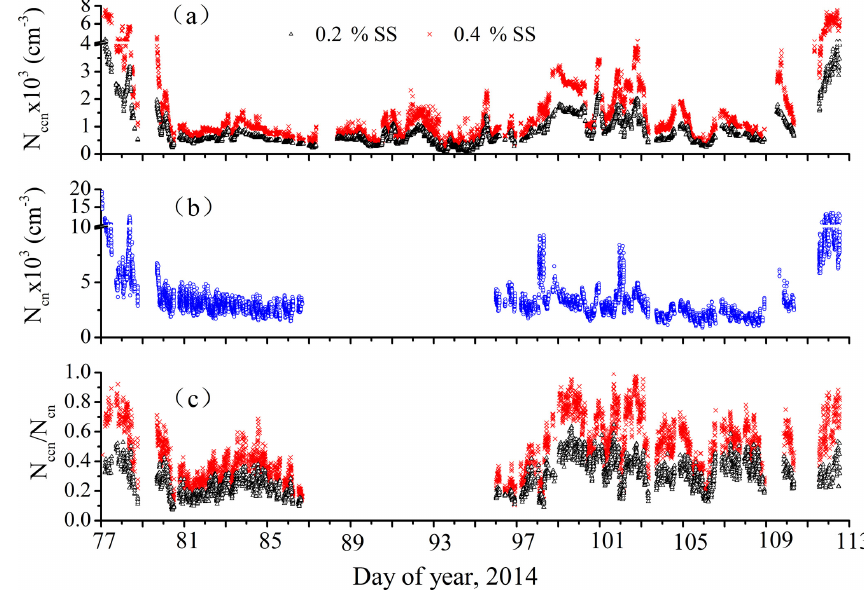
Figure 2. Time series of minutely averaged N cn , bulk N ccn and N ccn /N cn at SS of 0.2% and 0.4% during DOY 77–112, 2014. Table 1. Concentrations of CN and CCN, AR, mixing ratios of O 3 , and metrological conditions during DOY 81–108, 2014 over the